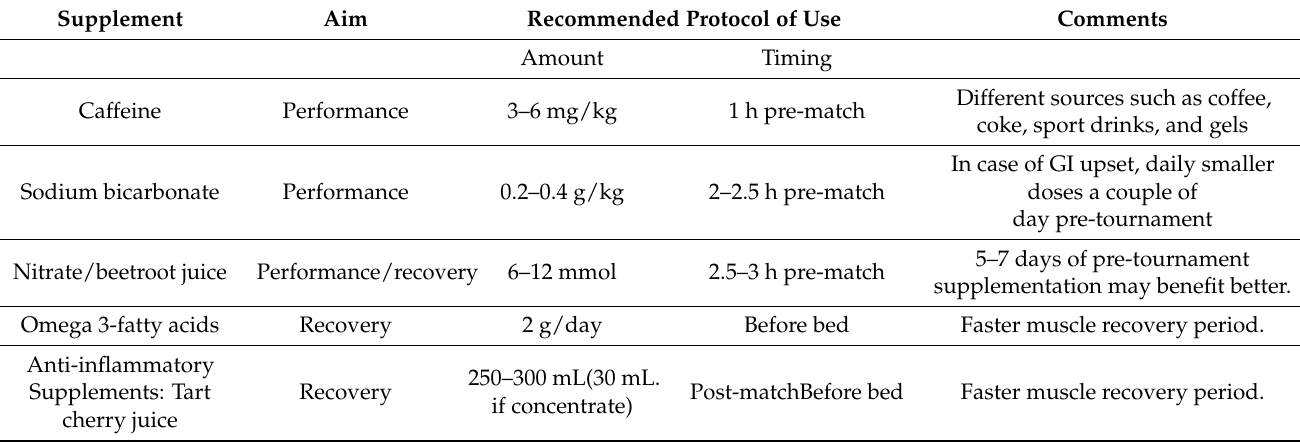
Table 2. Evidence-based [14] use of dietary supplements to benefit match